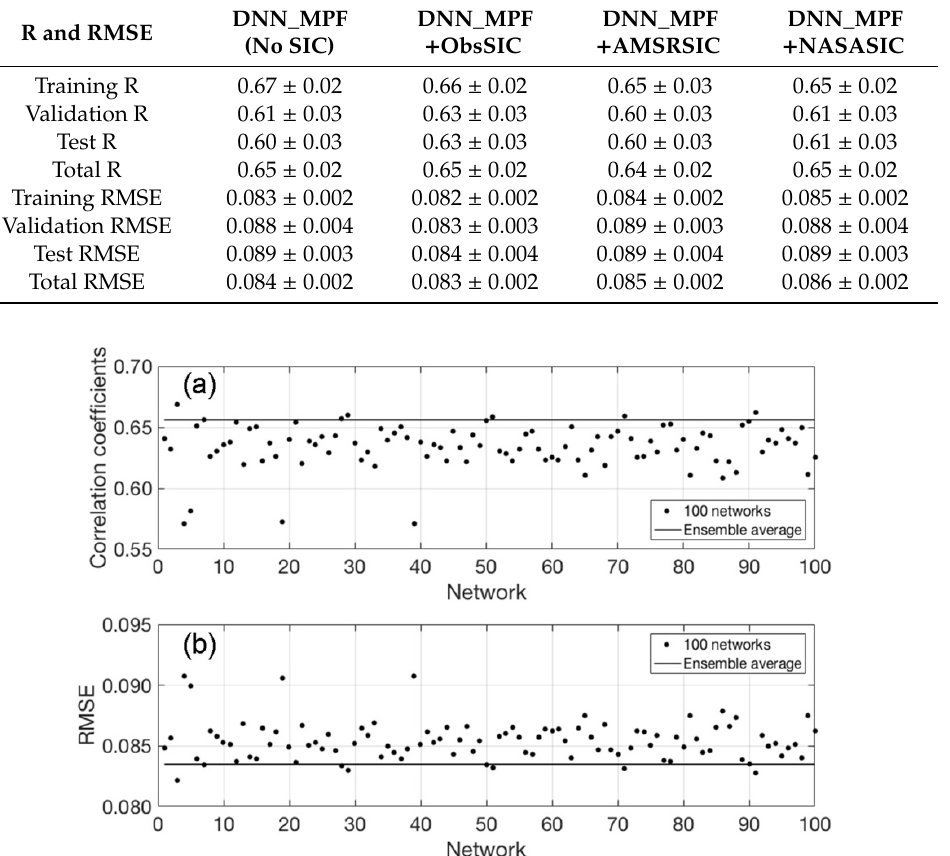
Figure 3. Correlation coefficients ( a ) and RMSE ( b ) between the observed MPF and the retrieved MPF from 100 networks and the ensemble average of the selected networks.